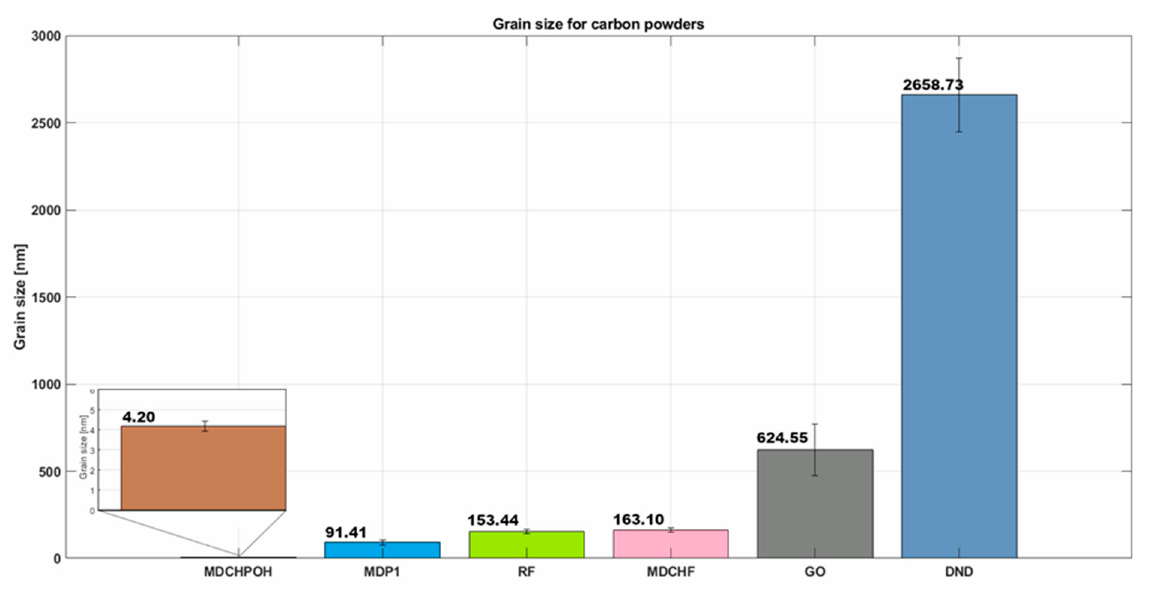
Figure 8. The comparison of grain sizes of tested carbon-based nanomaterials.